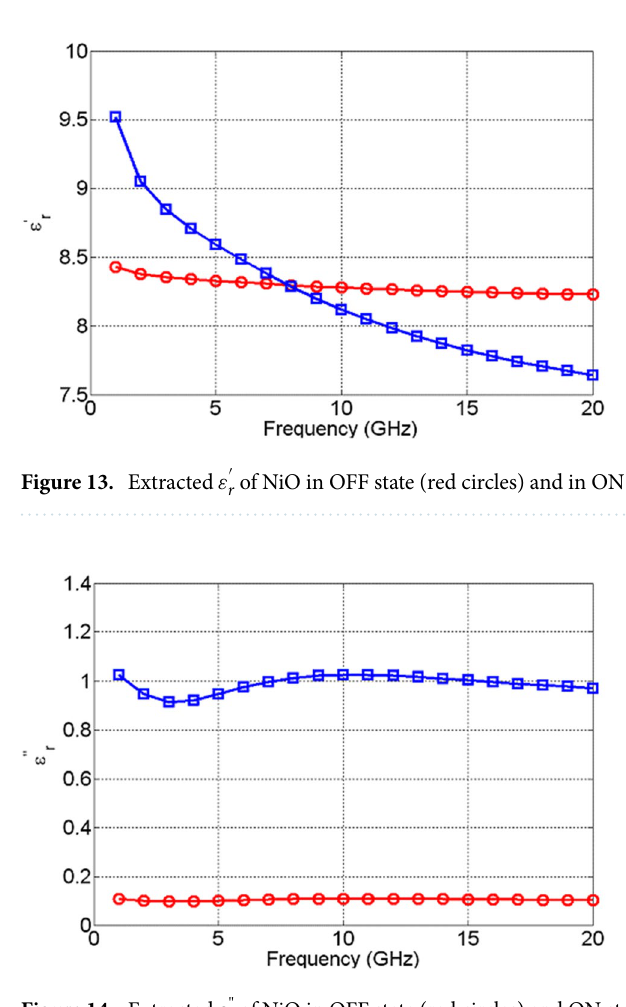
" Figure 14. Extracted ε r of NiO in OFF state (red circles) and ON state (blue squares).